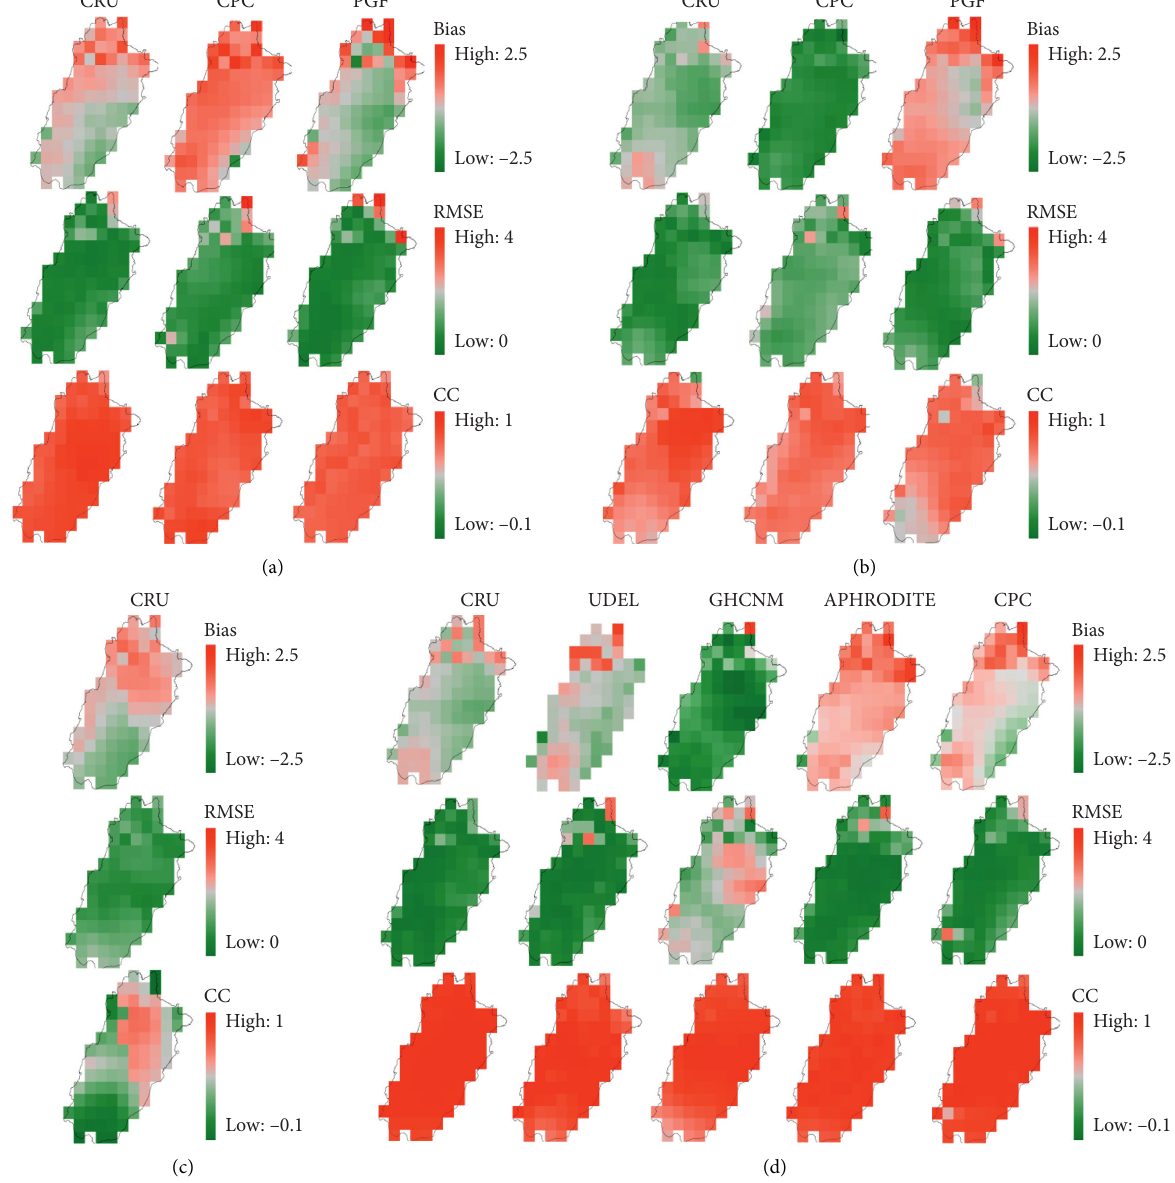
Figure 6: Spatial distribution of Bias, RMSE, and CC of temperature indices when comparing GDPs against observations for (a) T (b) T min , (c) DTR, and (d) T mean